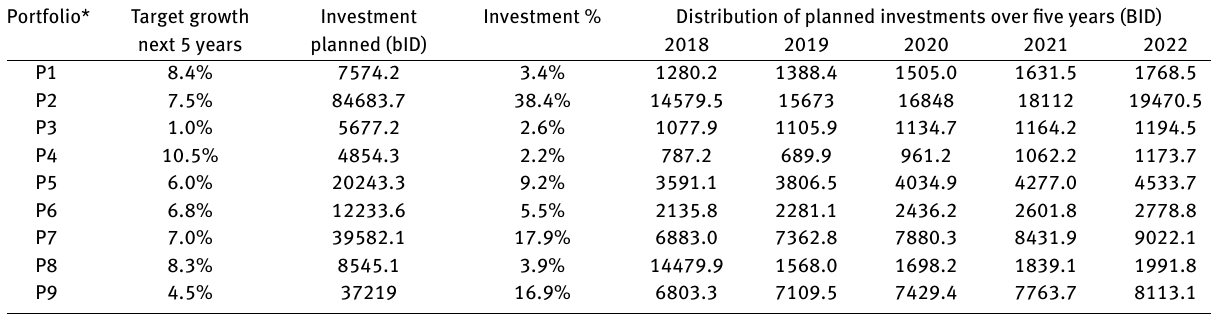
Table 8: Target growth rates for portfolios [32] Portfolio*